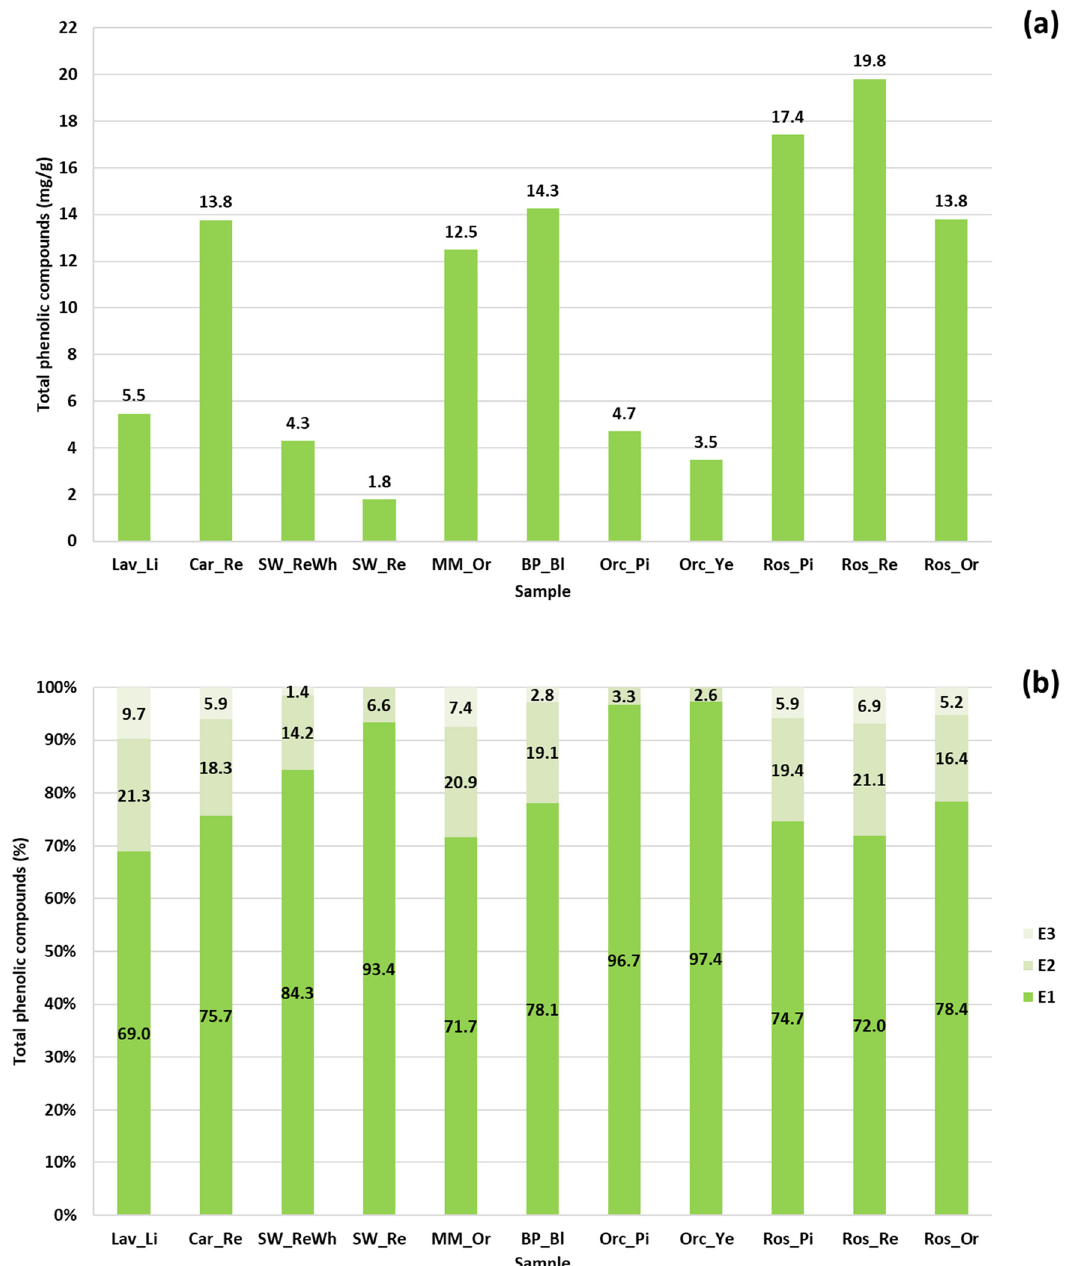
Figure 3: TPC in the fi rst extraction ( a ) and relative percentage of three extractions ( b )